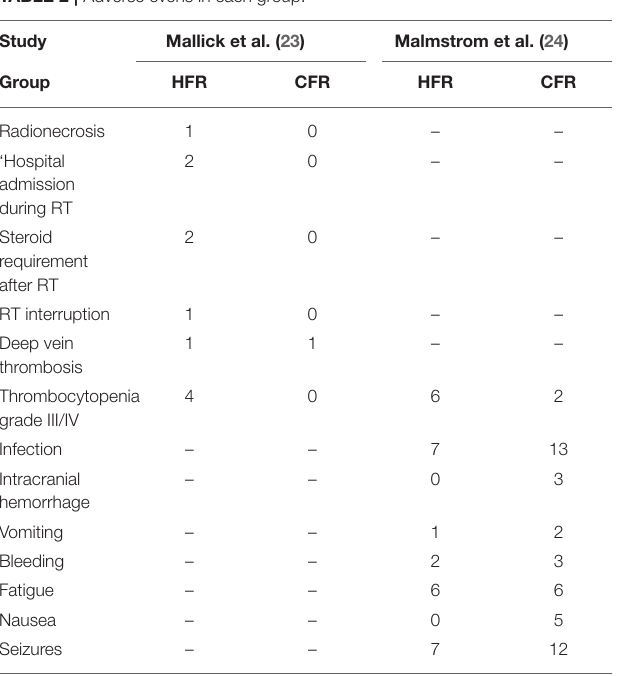
FIGURE 4 | Forest plots for progression-free survival between hoperfractionated radiotherapy (HFR) and conventional fraction radiotherapy (CFR). TABLE 2 | Adverse evens in each group.